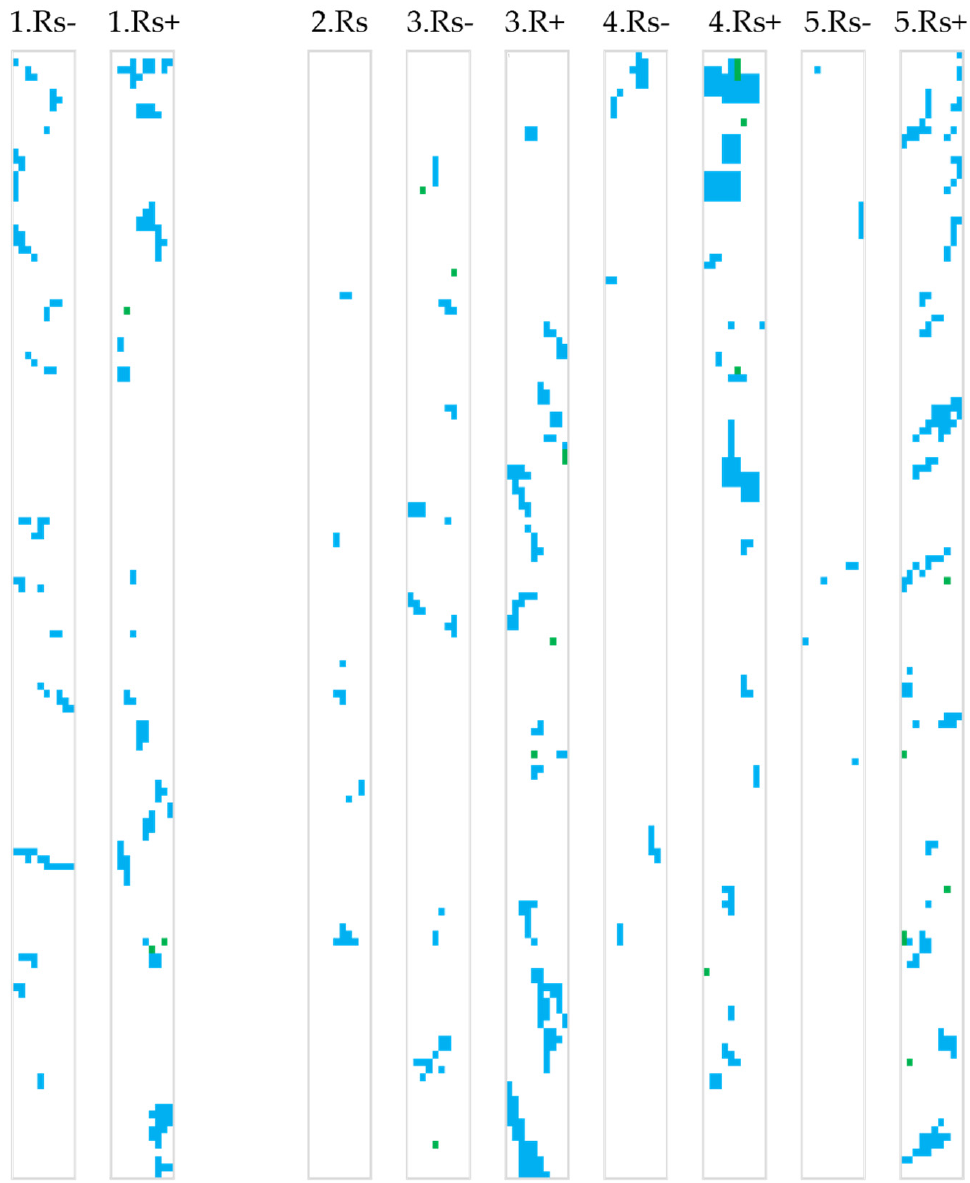
Figure 5. Resistance conditions (Rs) colonization strategy. Legend: 1-V1 (control variant)—untreated; 2-V2—organic (manure) treatment—10 t ha − 1 manure; 3-V3—low-mineral organic treatment— 10 t ha − 1 manure + 50 N 25 P 2 O 5 25 K 2 O; 4-V4—mineral treatment—100 N 50 P 2 O 5 50 K 2 O; 5- V5—high-mineral organic treatment—10 t ha − 1 manure + 100 N 50 P 2 O 5 50 K 2 O. Color Legend: blue—hyphae; red—arbuscules; green—vesicles. Minus( − ) sign—lower model of strategy; Plus(+) sign—upper model of strategy. Square color in mycorrhizal maps: hyphae—blue, vesicles—green (based on original color code [50]).